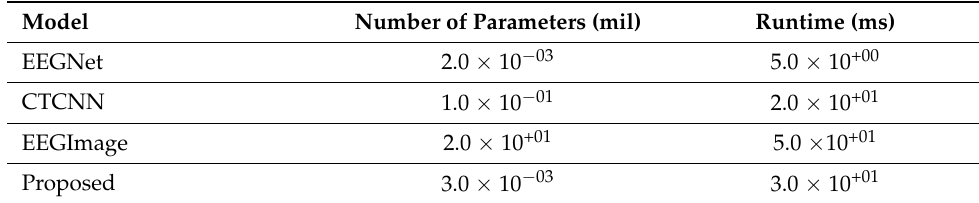
Figure 5. Comparison based on runtime and trainable parameters. Table 9. Comparison based on runtime and trainable parameters.